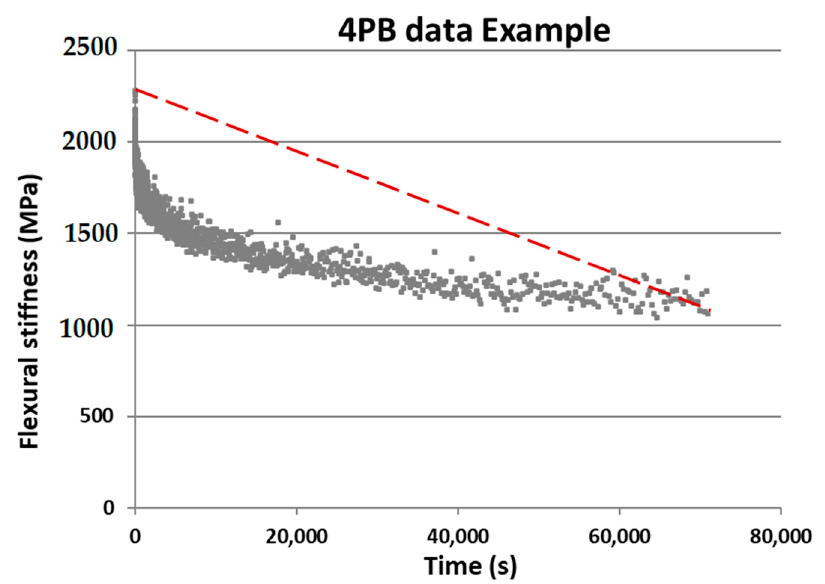
Figure 8. 4PB test data example, where the slope of the red dashed line shows the damage rate.